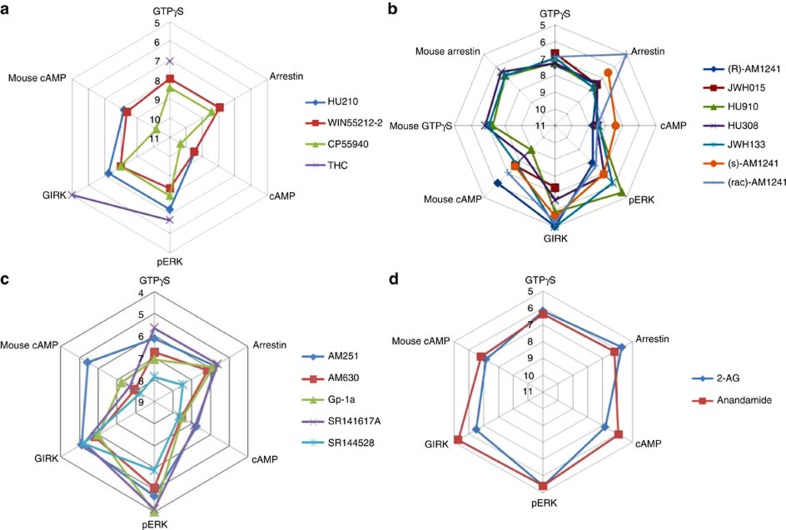
Radarplots of potencies of cannabinoid receptor reference ligands across different assays.(a) non-selective CBR agonists, (b) selective CB2R agonists, (c) antagonists, (d) endocannabinoids. These plots are a visualization of the differences in potency across different signalling pathways. All potency values are the mean of three independent experiments performed in duplicate.